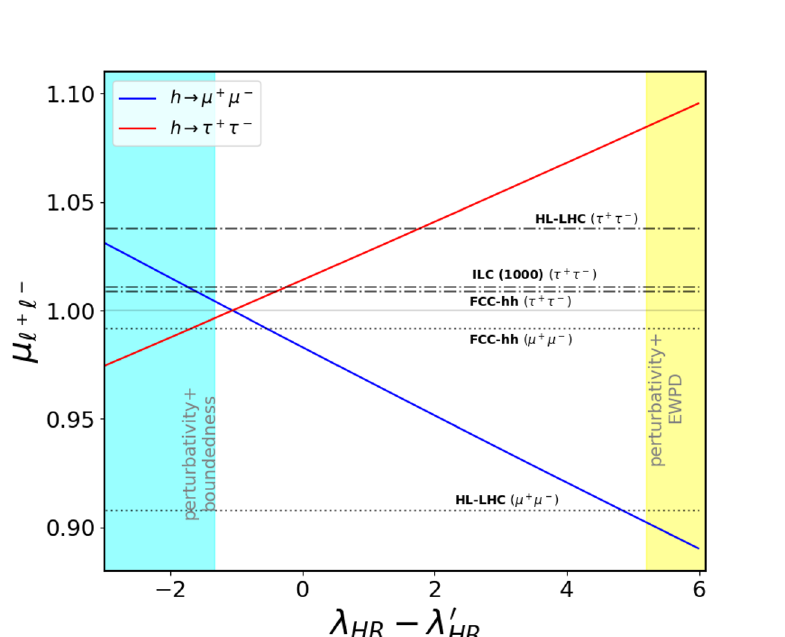
Figure 6 . Branching ratios of Higgs to dimuon (blue) and ditau (red) decays with respect to the SM predictions in our model as a function of the quartic coupling parameter ( λ HR − λ 0 horizontal dotted (dot-dashed) lines show the sensitivities of future colliders for the µ + µ − ( τ + τ − ) channel. The shaded regions in yellow and blue are excluded by perturbativity plus electroweak precision data, and by perturbativity plus boundedness of the potential constraints,